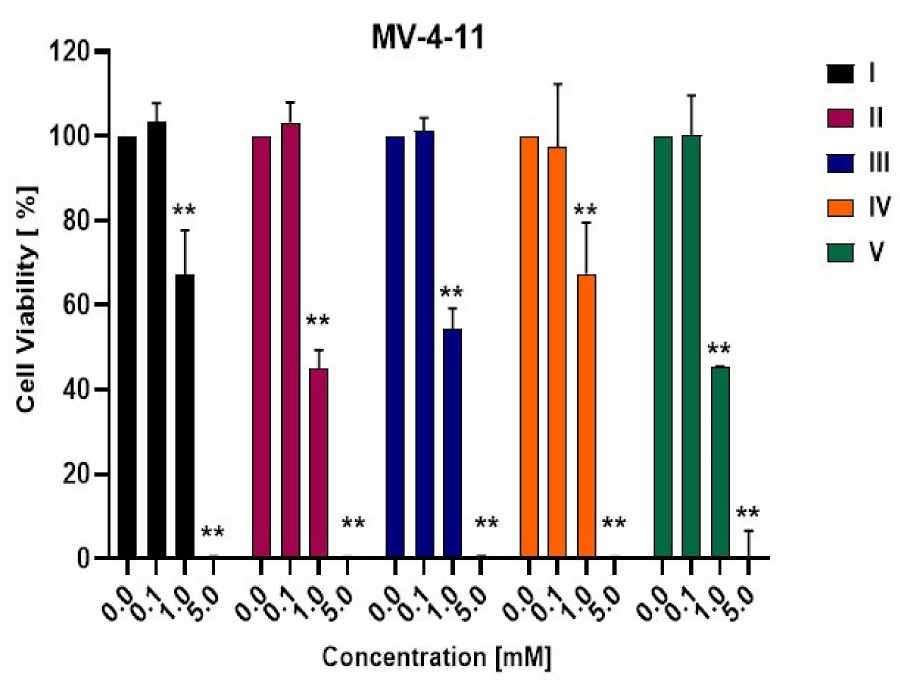
Figure 6. Compounds I – V demonstrates cytotoxicity in MV-4-11 starting from 1 mM. MV-4-11, an acute myeloid leukemia cancer cell line was treated for 48 h indicated concentrations of Com- pounds I – V . Cell survival was determined using the CellTiter-Glo ® Luminescent Cell Viability Assay (Promega, Madison, WI, USA). One-way ANOVA followed by Bonferroni post hoc test were used to assess significant differences between the treatment groups and the vehicle control. ** p < 0.01.